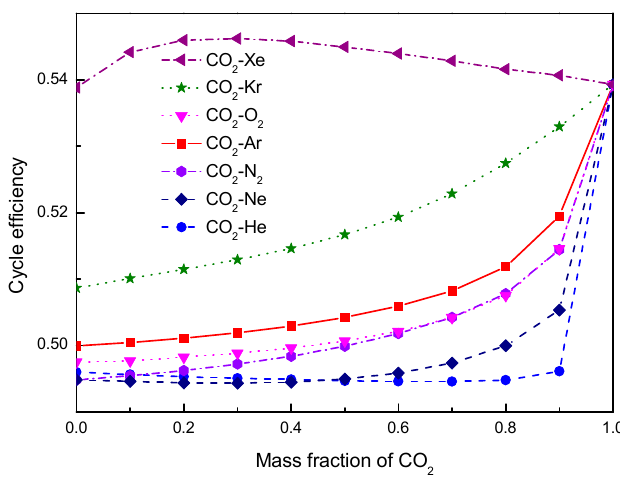
ffi ciency of mixtures at di ff erent mass fractions of CO Figure 6. Cycle efficiency of mixtures at different mass fractions of CO 2 . Figure 6. Cycle e